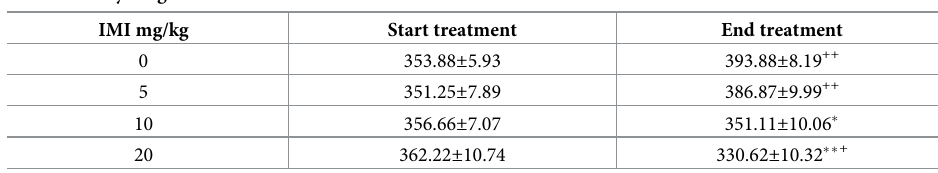
IMI: Imipramine. With respect to the corresponding vehicle treatment value � P < 0.01 �� P < 0.0001; with respect to the start treatment value of the corresponding group + P < 10 − 4 ++P < 10 − 6 (ANOVA followed by F-tests for